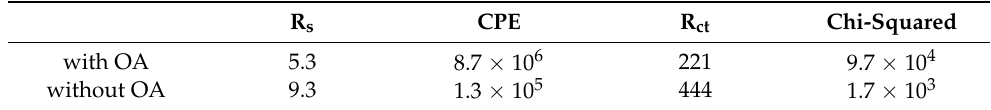
Figure 7. Impedance spectra profiles of LiFePO 4 /C electrodes prepared. ( a ) Nyquist diagrams (The inset is an equivalent circuit diagram). ( b , c ) Bode plots. Table 2. The specific values of each parameter in the equivalent